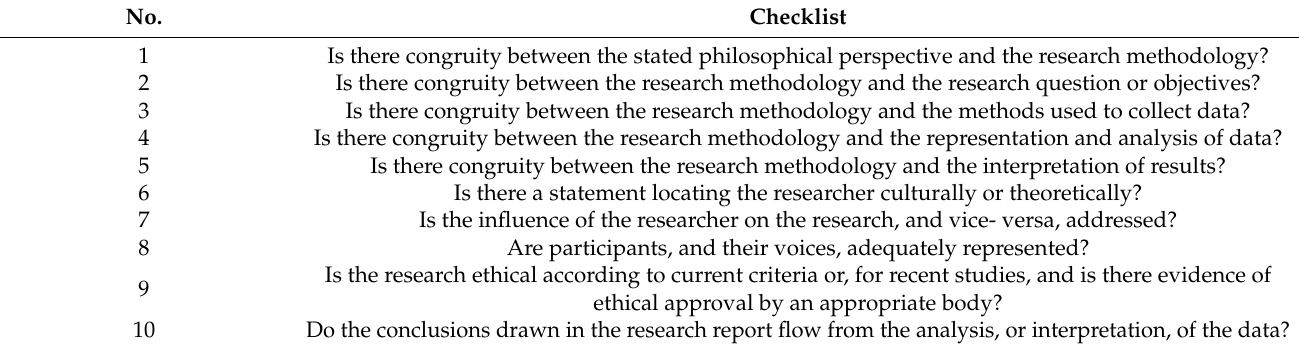
Table 2. Checklist for qualitative research in JBI Critical Appraisal Tool [85].